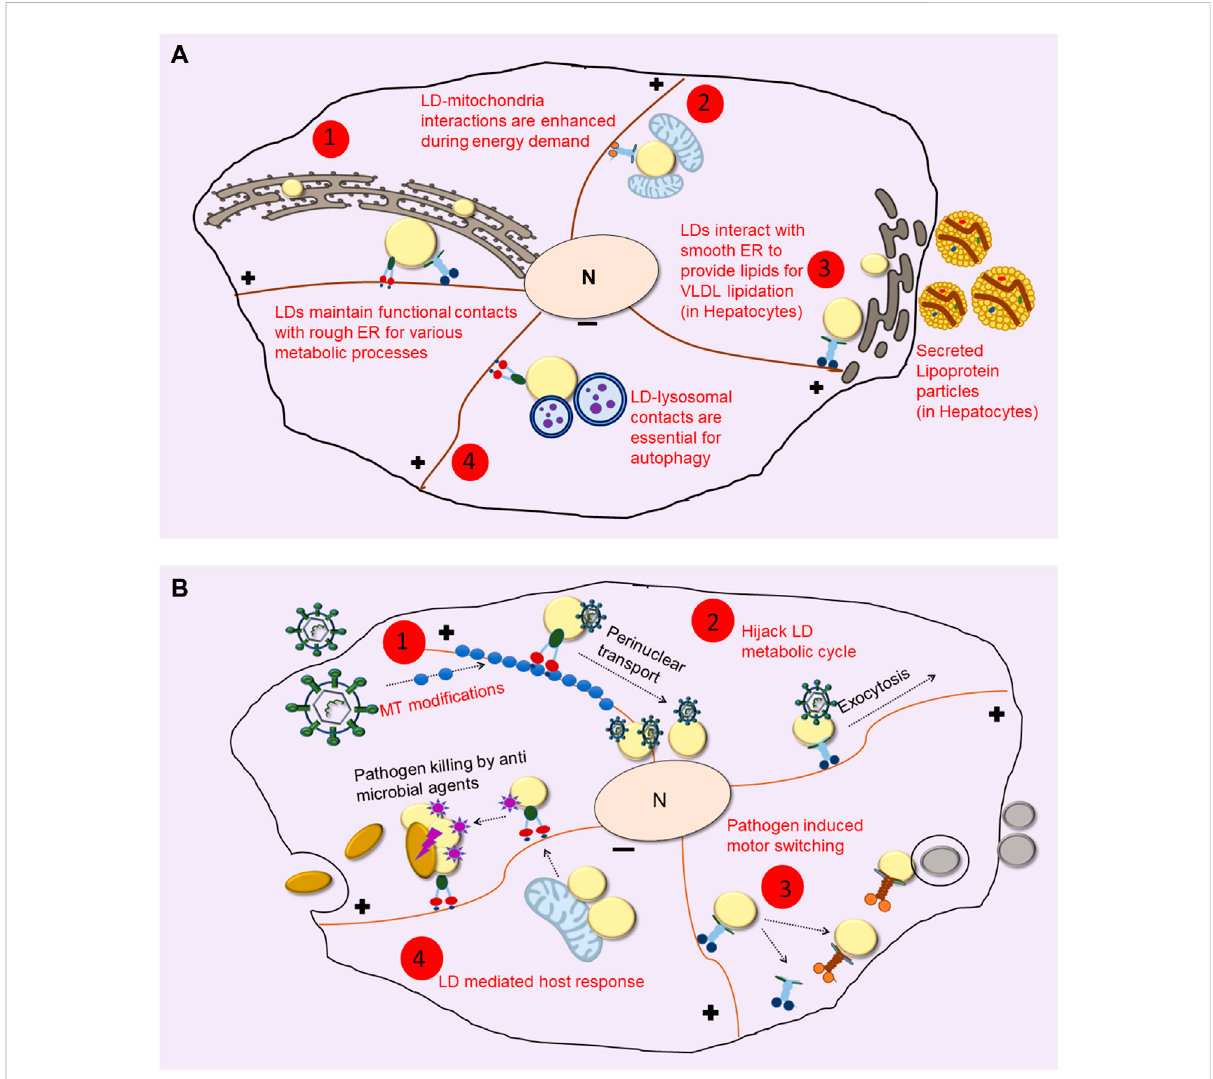
FIGURE 1 LDs Utilize theMicrotubule cytoskeletonto InteractwithotherOrganelles. (A) Evenafter itsbiogenesis from theER, LDs maintaincontactswith ER for protein and lipid traf fi cking during their life cycle (shown in 1). During nutrient deprivation and/or energy demand LDs interact with mitochondria for β -oxidation (asshown in 2).In hepatocytes, kinesin-1 drives LDs to smooth-ER atthecell peripherywhere it facilitates lipid transfer for lipidating VLDL particles which are then secreted out into blood for delivery to peripheral organs (depicted in 3). Extreme energy stress upregulateslipophagy,whereLDsareengulfedbyautophagosomestoderiveenergyandnutrientsforcellsurvival(shownin4). (B) Pathogenscause changes in LD dynamics and localization using different mechanisms. Some pathogens cause changes in microtubule (MT) organization and modi fi cations (shown in 1) to cause altered motor driven LD transport. Viruses such as HCV hitchhike with LDs and hijack their metabolic cycle for their entry into the nucleus as well as for the exocytosis of viral particles (as shown in 2). LDs often show differential recruitment of motors upon infection (shown in 3) to cause LD localization to pathogen containing vacuole and other organelles. As opposed to these, a counter defense mechanism used by the host is accumulation of anti-microbial proteins on LDs, which then act as immune hubs and help in elimination of the pathogen (shown in